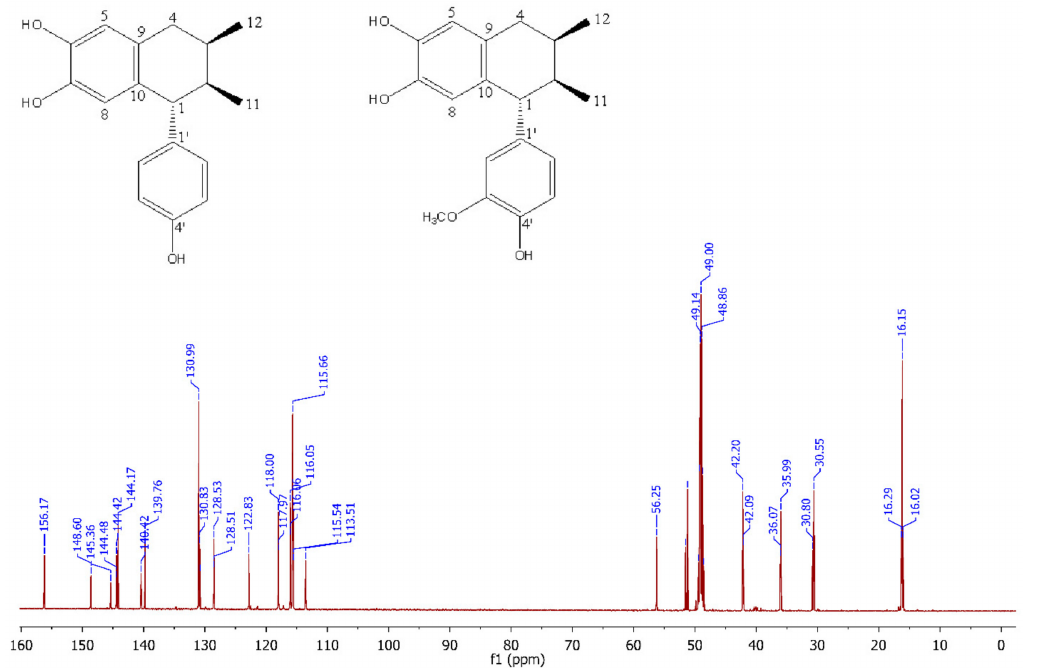
Figure A1. 1H NMR (CD3OD, 600 MHz) of 3 (cid:48) -demethoxy-6-O-demethylisoguaiacin ( 1 ) and 22 norisoguaiacin ( 2 ) 23.